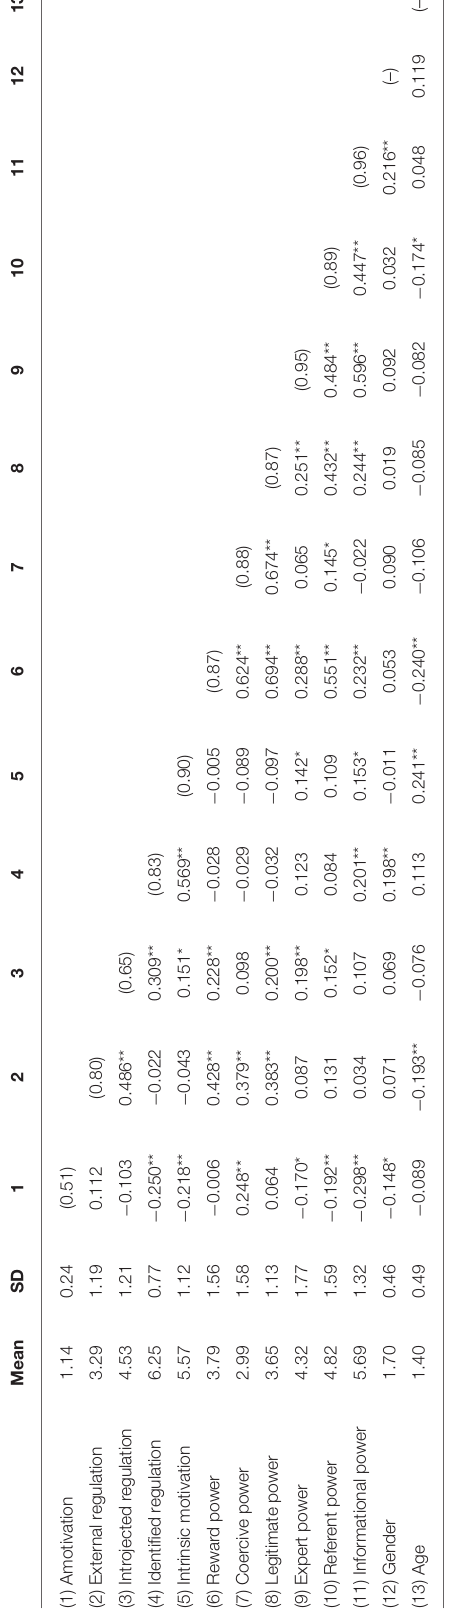
model comparison results from chi-square significance testing, and Figure 3 for Model 4, which was best-fitting to the data. For Model 4, standardized path coefficients are presented in Figure 3 . For that final model, endogenous variables’ r 2 values were: 0.18 for amotivation, 0.33 for external regulation, 0.13